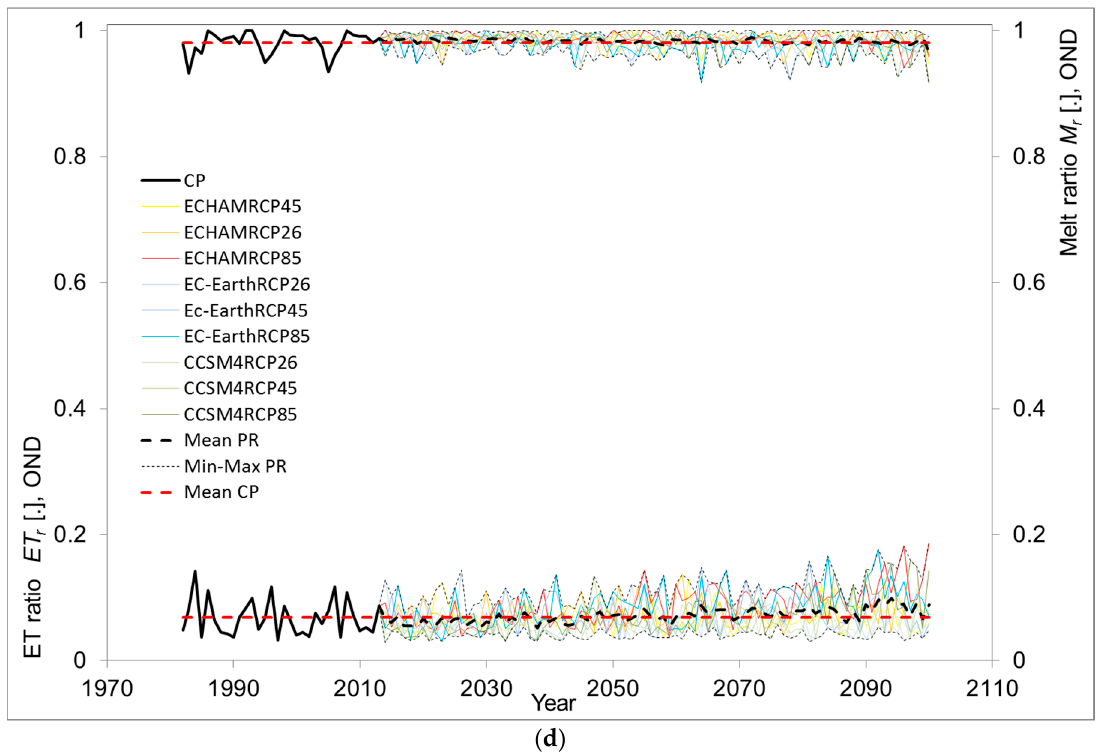
Figure 9. Rio Maipo at El Manzano. Evapotranspiration ratio ET r (lower y axis), and melt. ratio M r (upper y axis). ( a ) Summer JFM. ( b ) Fall AMJ. ( c ) Winter JAS. ( d ) Spring OND.